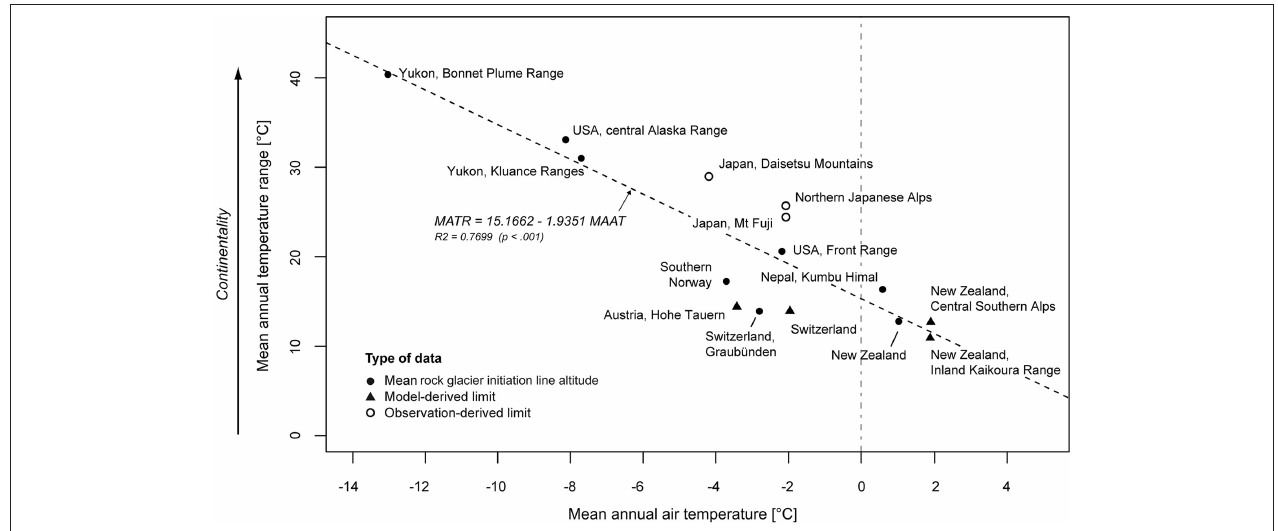
FIGURE 11 | Comparison of mean annual temperature range (MATR) and mean annual air temperature (MAAT) at mean rock glacier initiation line altitudes and estimated permafrost limits of the international permafrost sites. The comparison suggests the presence of a global trend of increasing MAAT at permafrost sites with decreasing